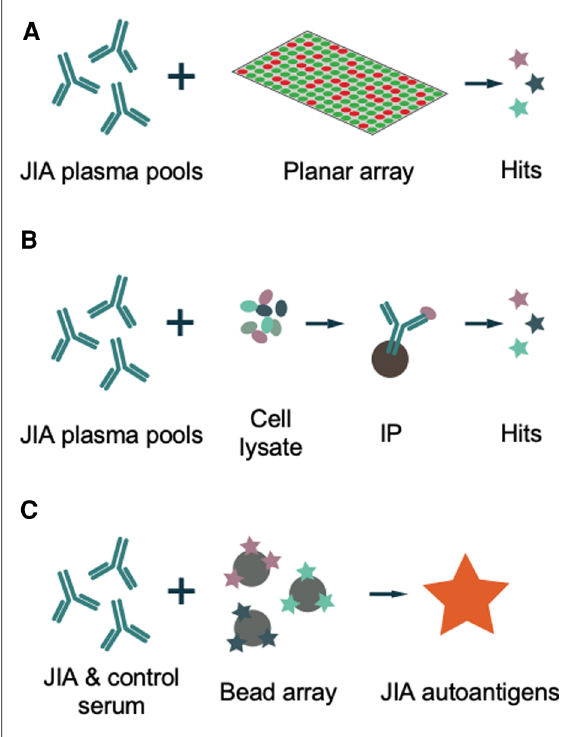
FIGURE 1 Schematic methodology. ( A ) JIA plasma is analyzed for reactivity towards 42,100 peptide antigens on a glass slide in a planar array. ( B ) JIA plasma is incubated with whole cell protein extracts, proteins captured by JIA IgG are immunoprecipitated (IP) and identi fi ed by mass spectrometry. ( C ) Hits from A and B are coupled to beads and reactivity analyzed in serum from a cohort of 56 patients with oligoarticular- or RF-negative polyarticular JIA, 8 of which with current or history of uveitis, to identify uveitis- related autoantigens.